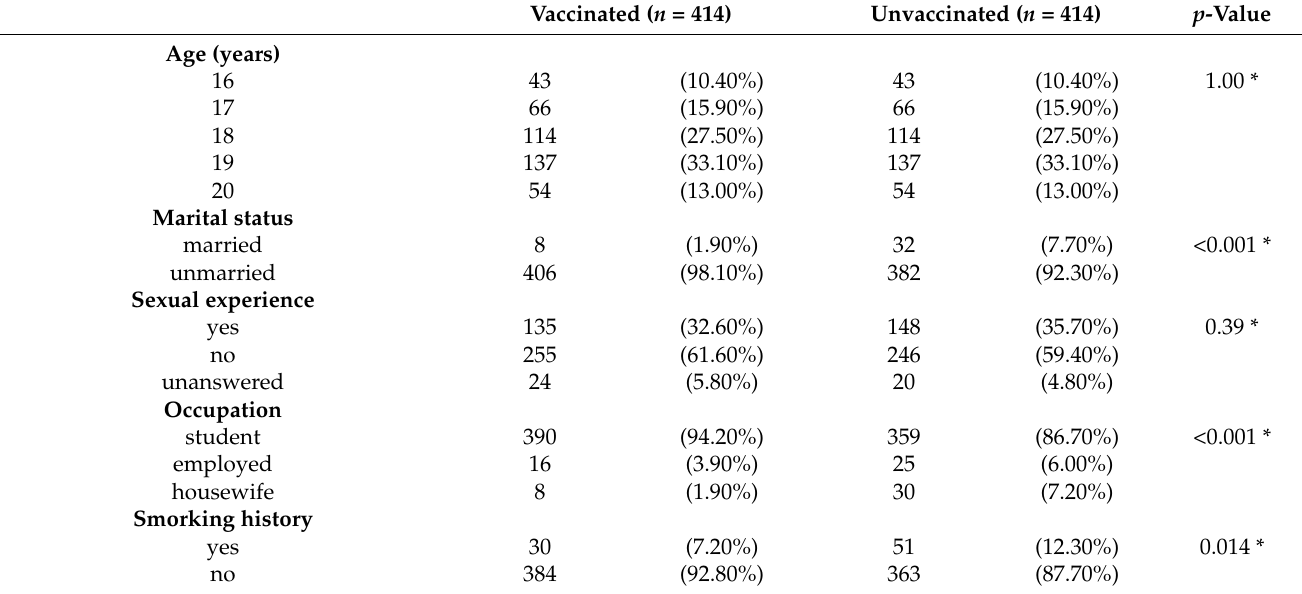
Table 1. Background of participants in this Internet